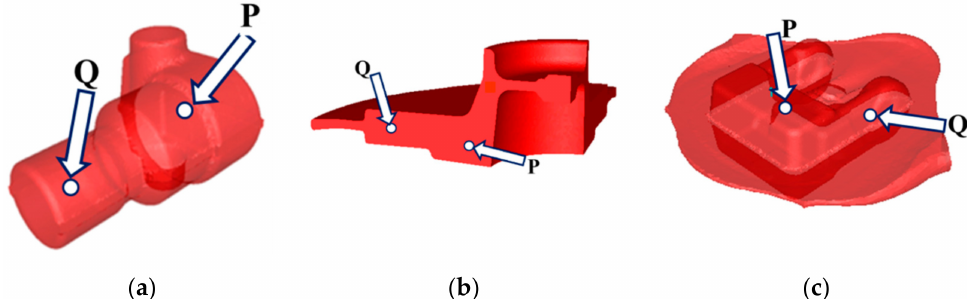
Figure 1. Schematic illustration of the investigated forgings with the locations of sensors: ( a ) adapter, ( b ) flange, ( c )